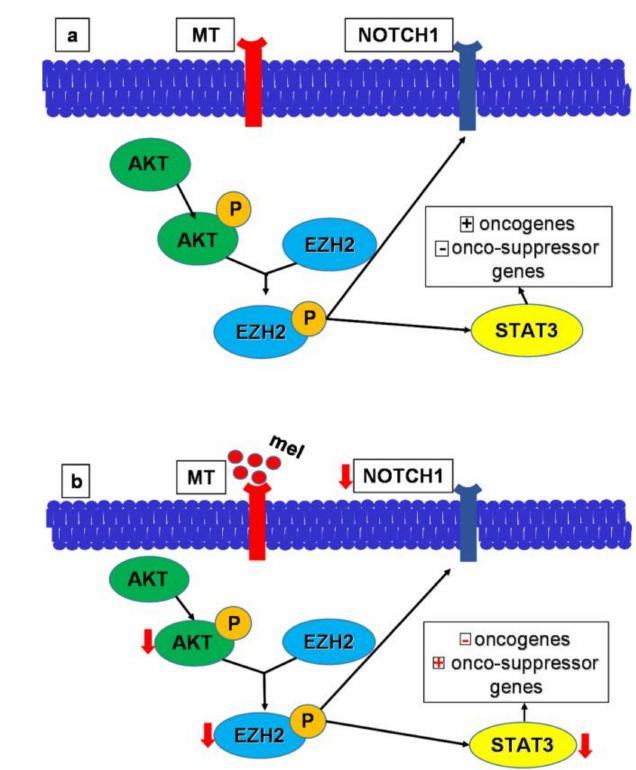
Figure 1. The interaction of melatonin with its membrane receptors induces alterations in the activity of protein kinase B (Akt)–enhancer of zeste 2 polycomb repressive complex 2 subunit ( EZH2 )–signal transducer and activator of transcription 3 (STAT3) and EZH2 –Notch1 pathways in Akt-overexpressing glioma stem-like cells (GSCs). Melatonin prevents EZH2 activation and reduces EZH2 pro-oncotic e ff ects such as the upregulation of Notch1. ( A ) Scheme summarizing the basal activity of Akt–EZH2–STAT3 and EZH2–Notch1 pathways. ( B ) Scheme summarizing the e ff ects induced by melatonin on Akt–EZH2–STAT3 and EZH2–Notch1 pathways. Mel: melatonin; MT: melatonin receptor; P: